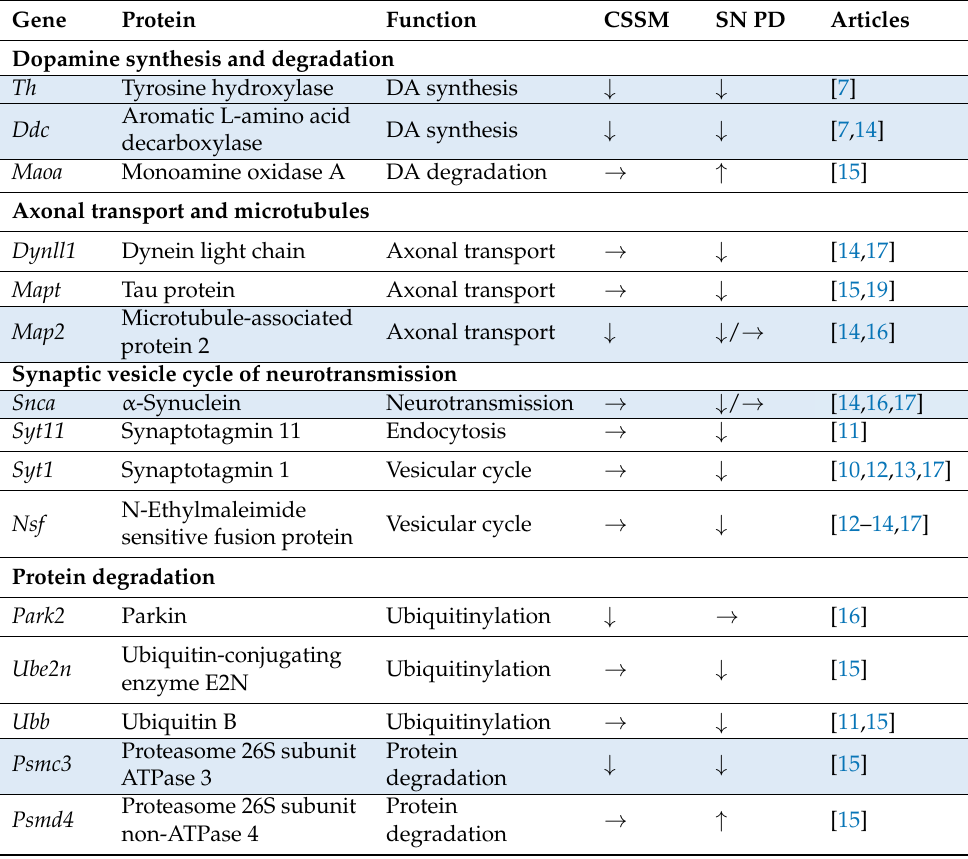
Table 2. Comparison of gene expression for the dopaminergic phenotype, synaptic neurotransmission, and neurodegeneration proteins in the substantia nigra of mice in the clinical stage of Parkinson’s disease model (CSSM) and in the substantia nigra of patients with Parkinson’s disease (SN PD). Gene